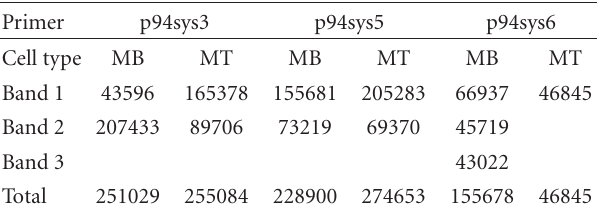
Table 1: Quantification of the expression of calpain 3 transcripts in wild type myoblasts and myotubes. These data were obtained from the gel electrophoresis of the RT-PCR reactions using the primer pairs p94sys3, p94sys5 and p94sys6 on murine myoblast (MB) or myotube (MT) mRNA (see Figure 1(b)). The gel and the corresponding quantification are representative of 3 di ff erent experiments where similar results were observed. These results have to be taken qualitatively since the experiments were performed by classical RT-PCR and not by quantitative RT-PCR. Numbers are given in arbitrary units.